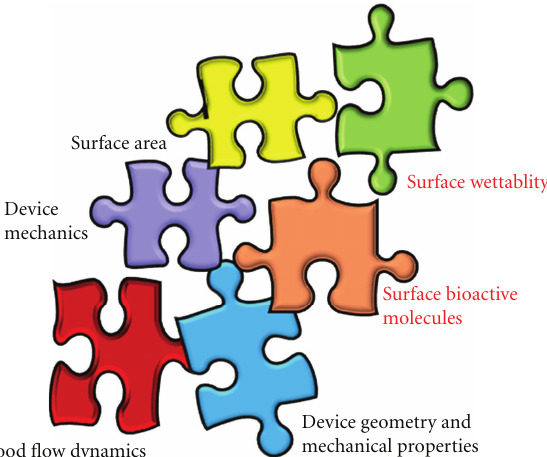
Figure 1: Haemocompatibility-determining factors in a cardiovas- cular device; marked in red are areas of interest in this